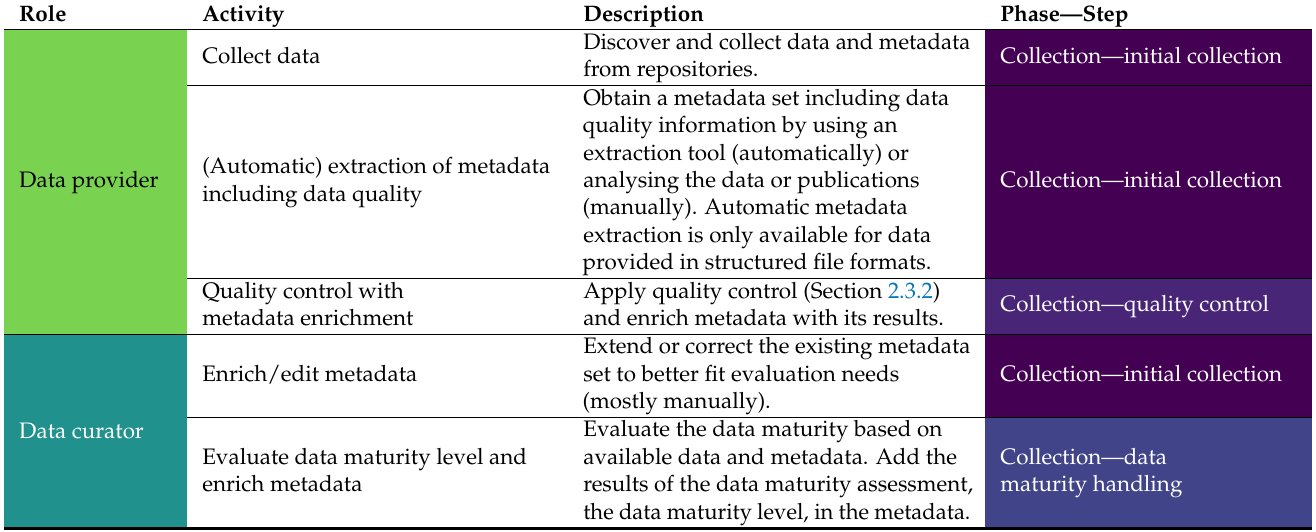
Table 10. Roles and their activities with descriptions at collection